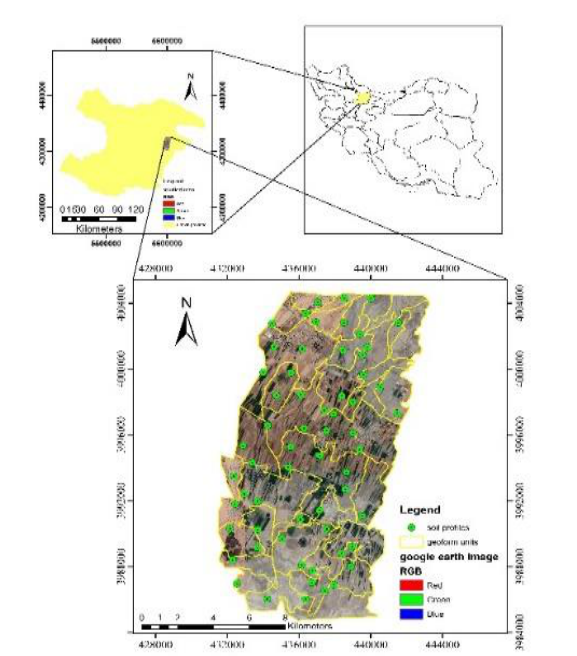
Figure1 . Location of the study area with Pedon